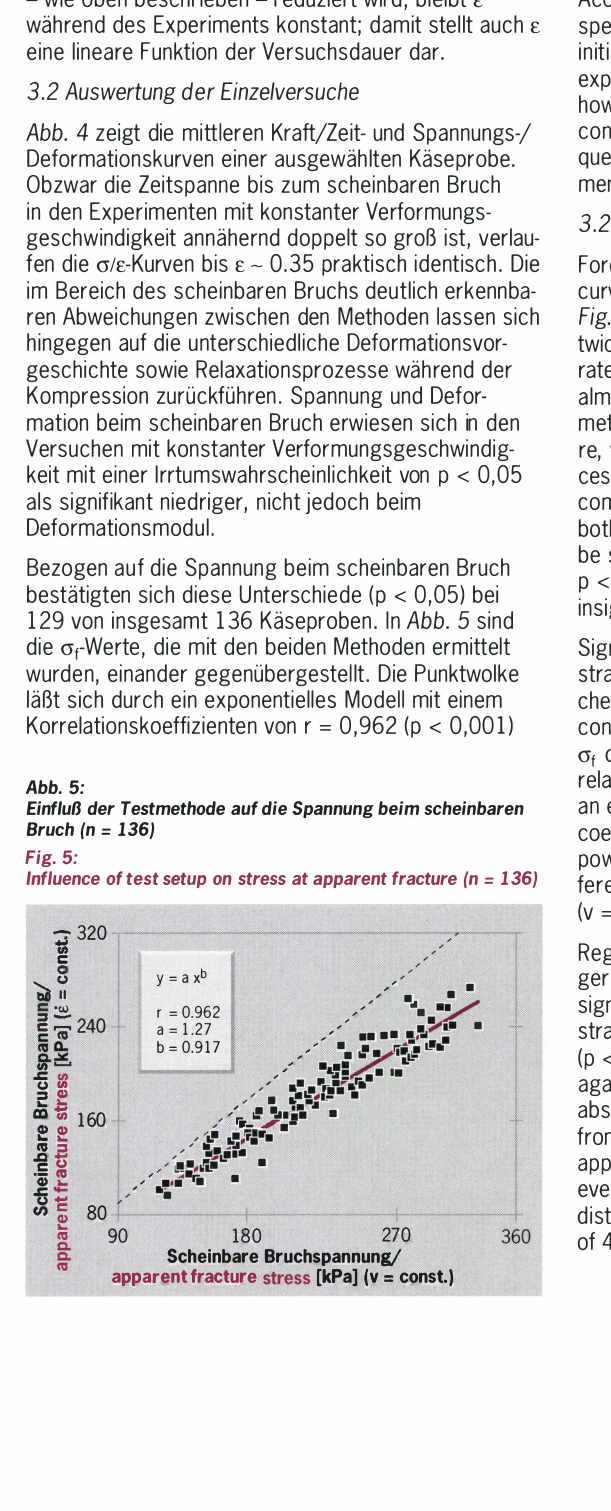
Fig. 4: Effect of test setup on rheological curves of a selected cheese sample. 1, constant speed; 2, constant strain rate. Explanation of symbols, see Fig. 1 Fig. 38, respectively. Variations in actual crosshead speed (19.2-20.7 mm min- 1 ) in the constant speed chronous data transmission via different